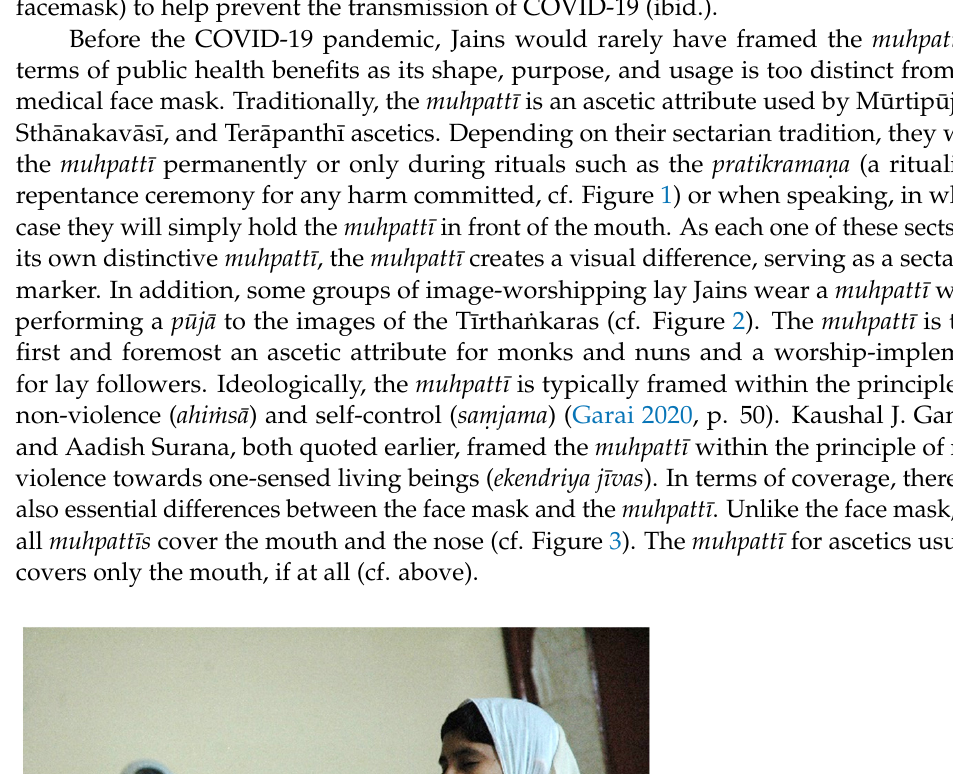
Figure 2. Jain lay follower performing m ū rti p ū j ā wearing a muhpatt ī . Internet photo.